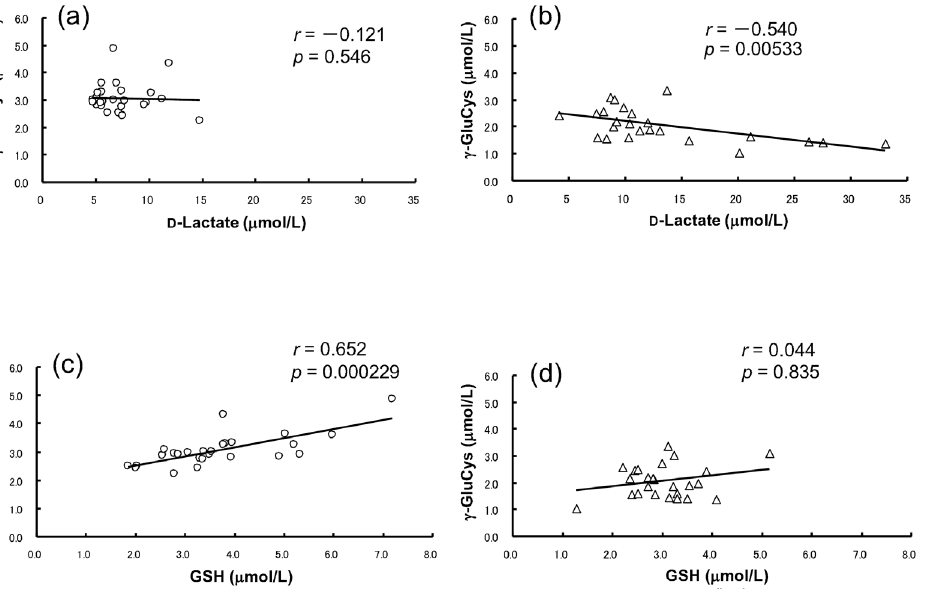
Figure 3. Correlation plots of D-lactate and c -GluCys serum levels in controls (a) and in patients with schizophrenia (b), and between GSH and c -GluCys in controls (c) and in patients with schizophrenia (d).